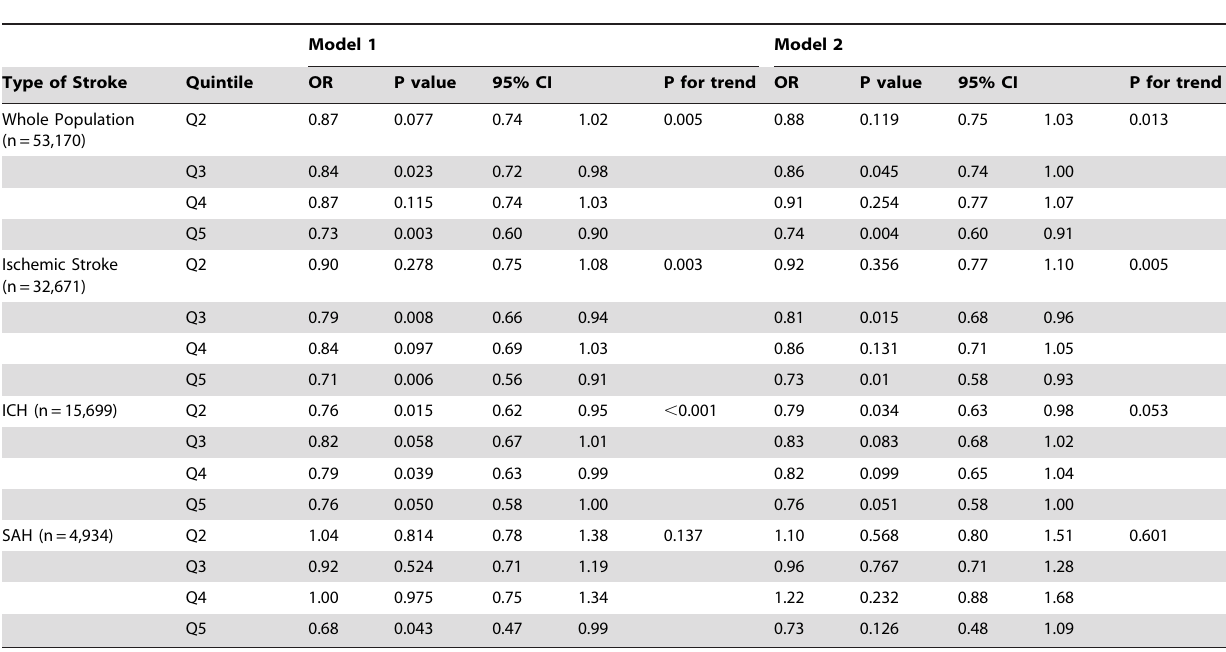
Table 10. Associations between total comprehensive stroke care (CSC) scores separated into quintiles (Q1: 4–12, Q2: 13–14, Q3: 15–17, Q4: 18, Q5: 19–23) and in-hospital mortality of patients after all types of stroke (a), ischemic stroke (b), intracerebral hemorrhage (ICH) (c), and subarachnoid hemorrhage (SAH) (d), model 1: after adjustment for age, sex, and initial level of consciousness; and model 2: after adjustment for age, sex, initial level of consciousness, and incidence of hypertension, hyperlipidemia, and diabetes mellitus.